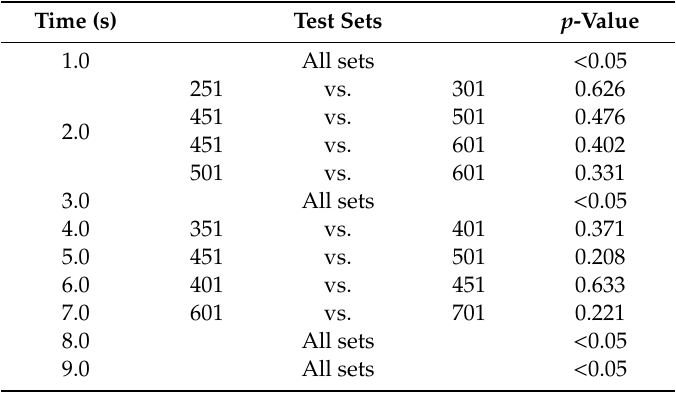
Table 2. Results of paired t -test.